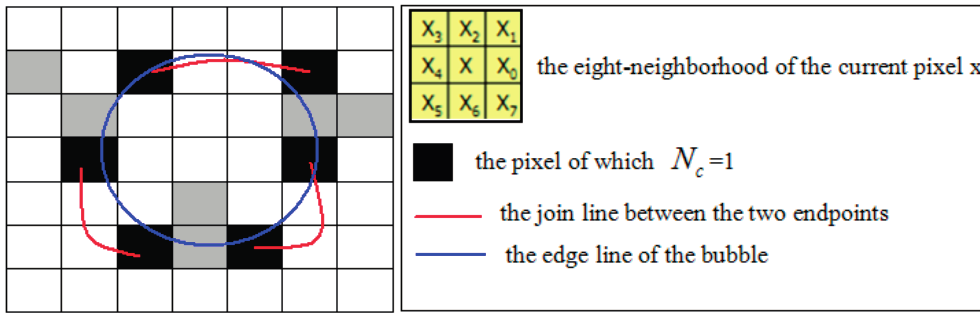
Figure 10. Gap linking diagram between the two endpoints and the representation of the pixels in the eight-neighborhood of the detecting pixel x